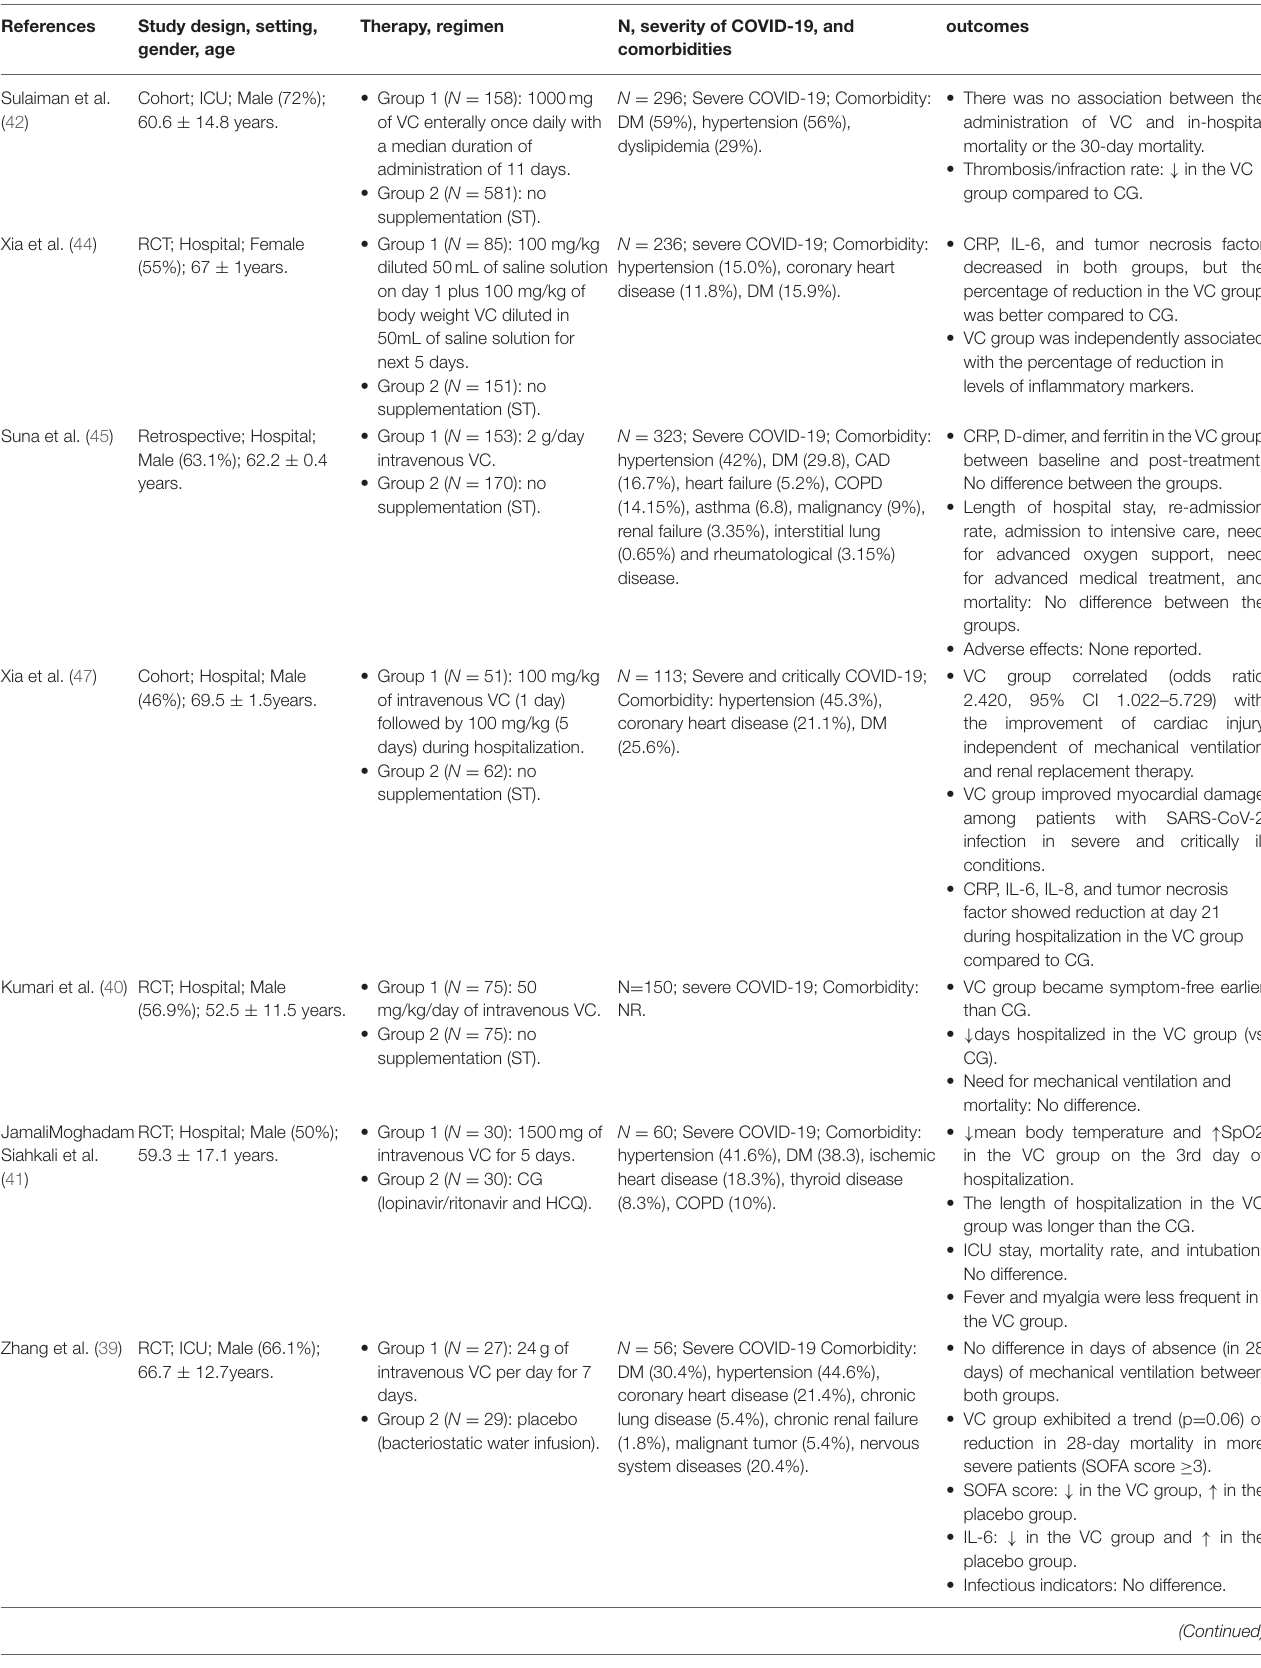
TABLE 3 | Summary of findings from studies that included vitamin C supplementation in the COVID-19 treatment.